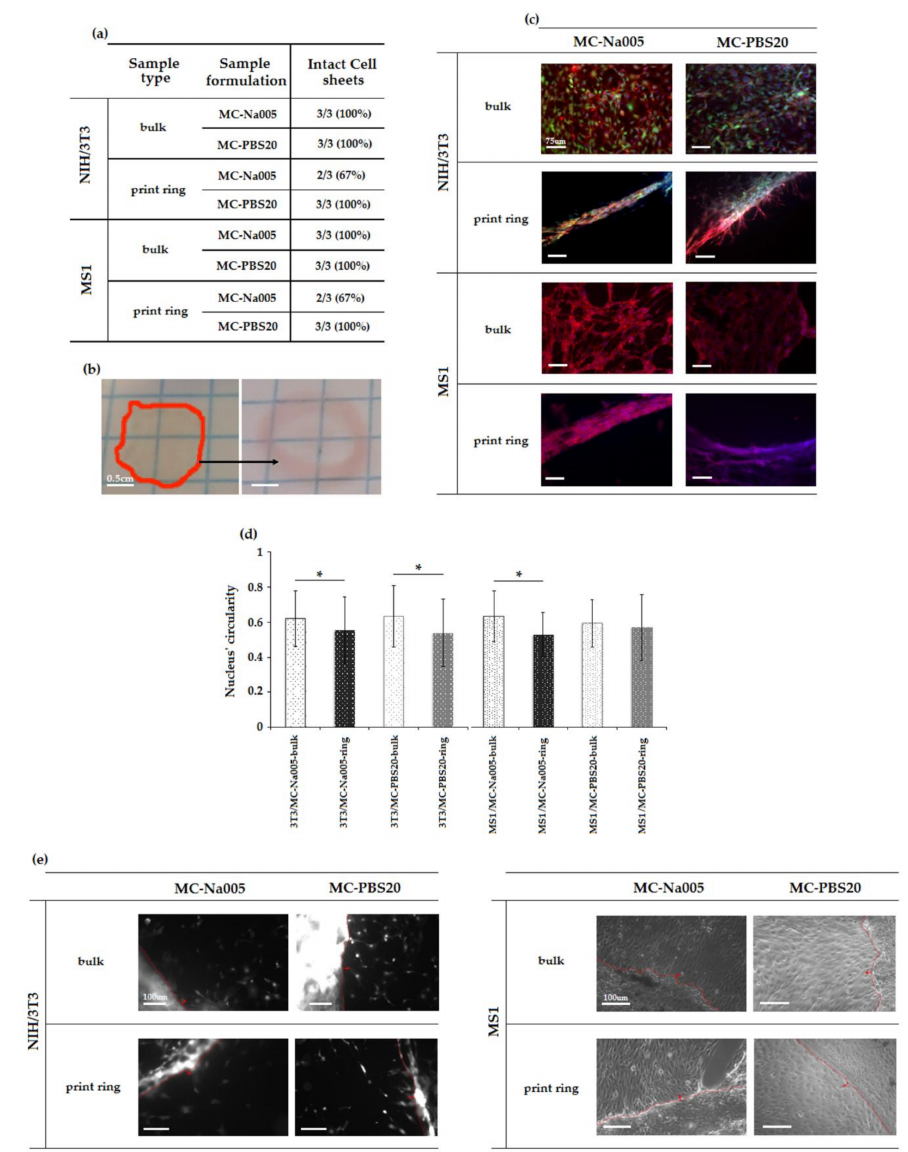
Figure 8. Characterization of the cell sheets (CS) obtained by culturing NIH/3T3 and MS1 cell phenotypes on the MC-based hydrogel formulations under study (MC-Na005 and MC-PBS) for the two specimen types (bulk and printed ring). ( a ) Efficiency of CS detachment. ( b ) Representative macro image of detached CS: left) NIH/3T3 CS detached from MC-PBS20 bulk hydrogel, right) MS1 CS detached from MC-PBS20 printed ring hydrogel. Scale bar = 0.5 cm. ( c ) Fluorescence images of NIH/3T3 and MS1 CS detached from MC-Na005 and MC-PBS20 hydrogels in bulk and printed ring shape. ( d ) Circularity of nuclei of the CS obtained for the different combinations of MC-based hydrogel/specimen type/cell phenotype. ( e ) Fluorescence and optical microscopy images of CS cultured for 6 days in a fresh TCPS; cell migration from the CS to the well bottom can be